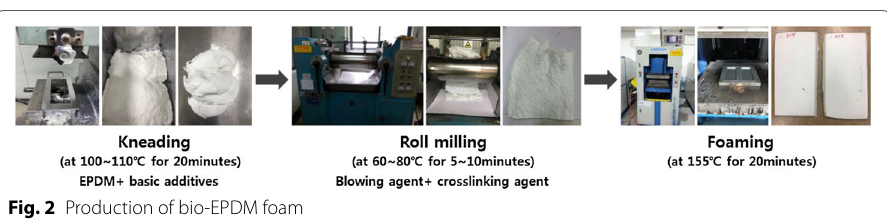
Fig. 2 Production of bio‑EPDM